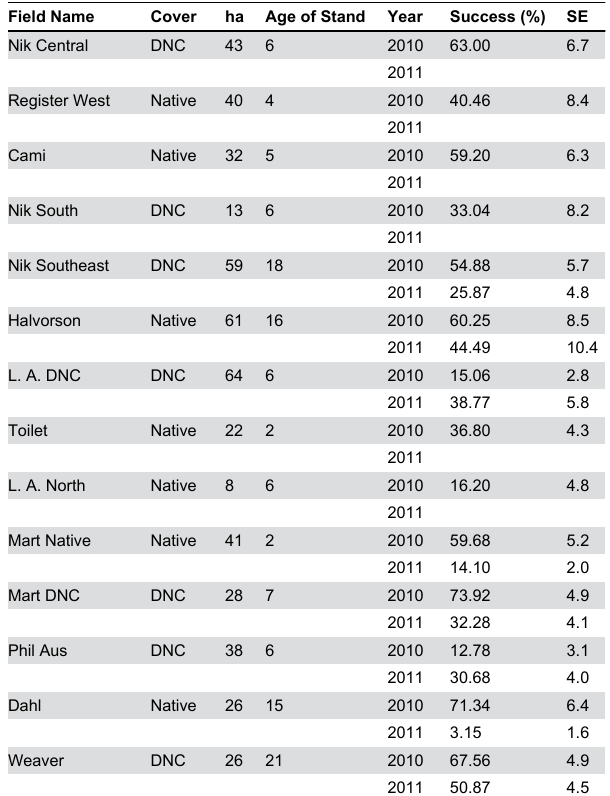
Table 1. List of study sites including field name, type of cover, size of field, age of stand (years since field was seeded as of 2010) and the nest success and standard error during 2010-11 field